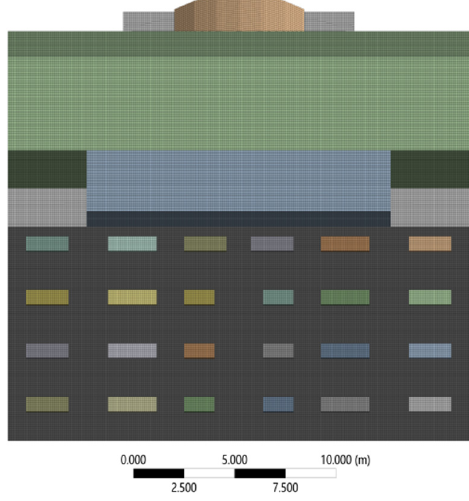
Figure 6. South-facing horizontal sun visor structure grid.